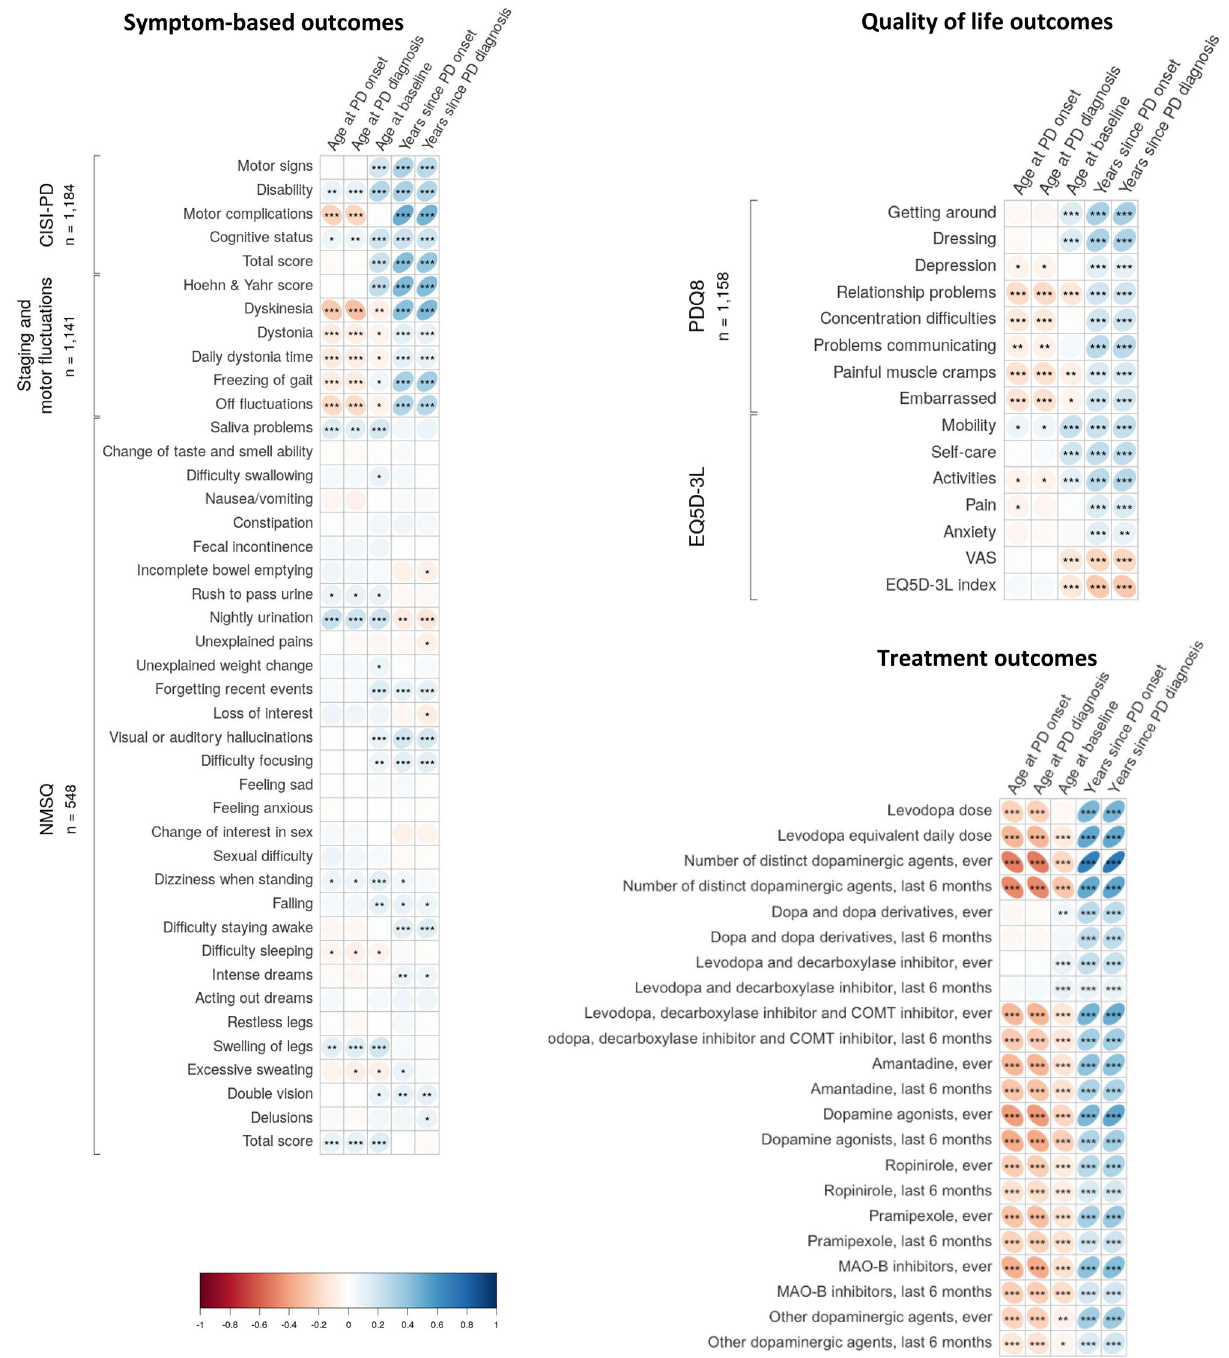
Figure 1. Baseline Spearman correlations between time variables (age at Parkinson’s Disease onset, age at Parkinson’s Disease diagnosis, age at baseline, years since Parkinson’s Disease onset, years since Parkinson’s Disease diagnosis), and respectively, symptom-based outcomes, Health related Quality of Life outcomes, and treatment